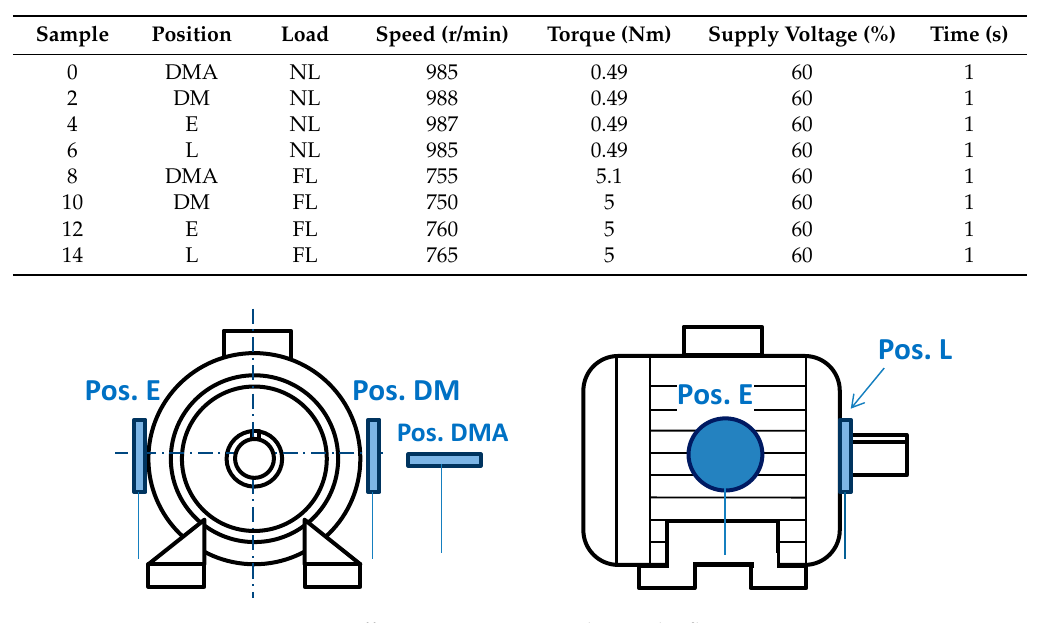
Table 2. Characteristics of the experiment for the damaged motor with a broken bar during start-up.